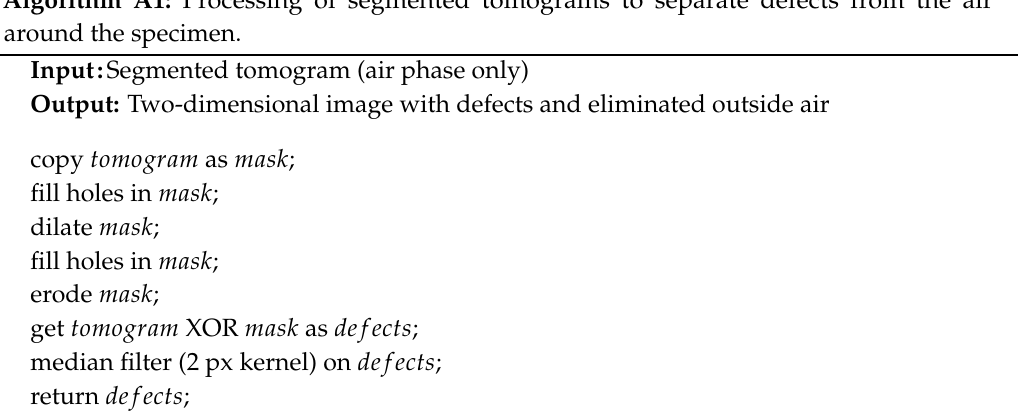
Algorithm A1: Processing of segmented tomograms to separate defects from the air around the specimen.